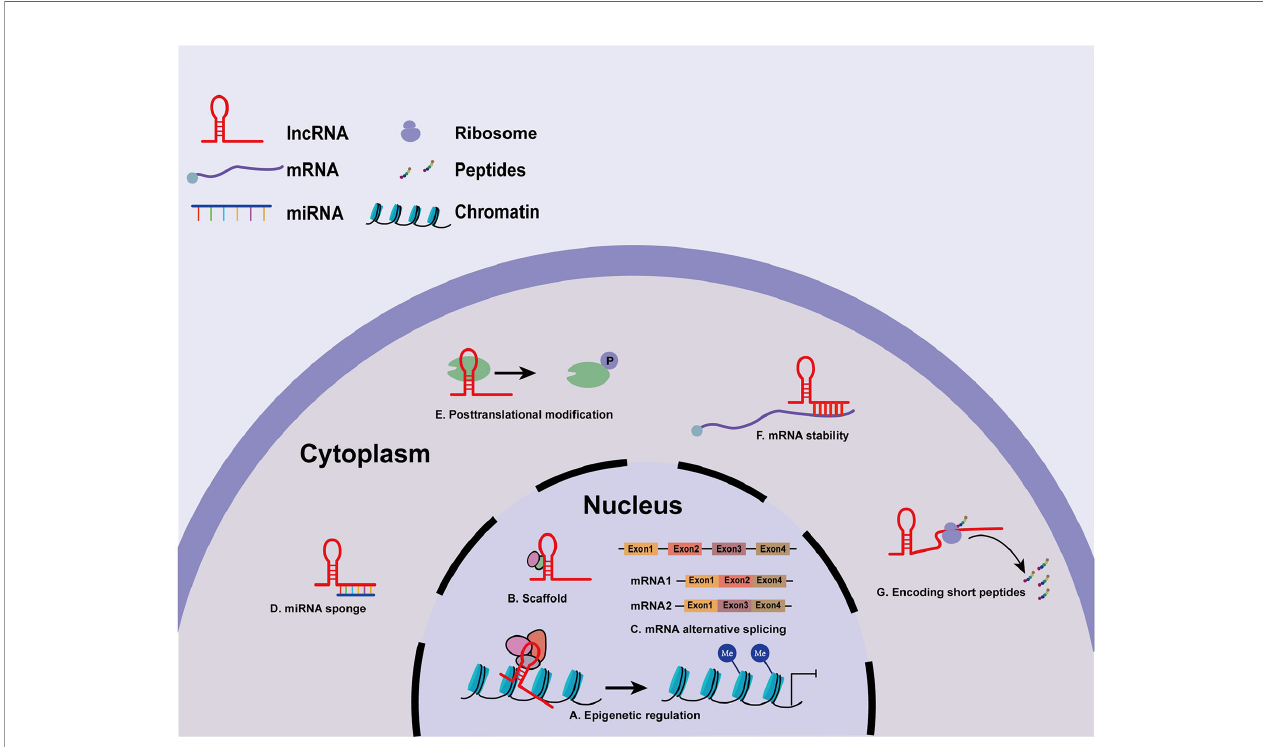
FIGURE 1 | Molecular mechanisms of lncRNAs. (A) LncRNAs modulate histone modi fi cation and chromatin remodeling. (B) LncRNAs serve as scaffolds for various proteins. (C) Nuclear lncRNAs participate in mRNA processing. (D) LncRNAs act as miRNA sponges or ceRNAs in regulating miRNAs. (E) LncRNAs regulate the stability and posttranslational modi fi cations of some proteins. (F) lncRNAs stabilize mRNAs. (G) lncRNAs encode functional small